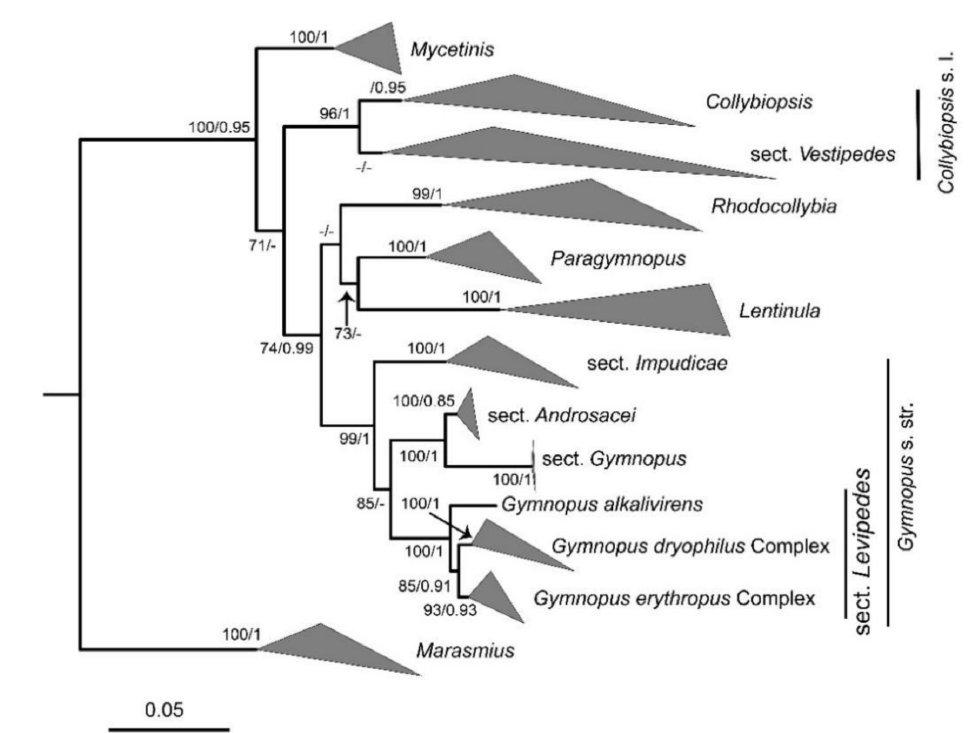
Figure 1. Bayesian 50% majority-rule consensus tree from the ITS and nLSU analyses. Support values at the nodes consist of BPPS ≥ 0.90 and BS ≥ 70; unsupported nodes under BPPS 0.5 are collapsed. The major clade is simplified, representing genus-level groups, as depicted in the figure. The outgroup consists of members of Marasmius